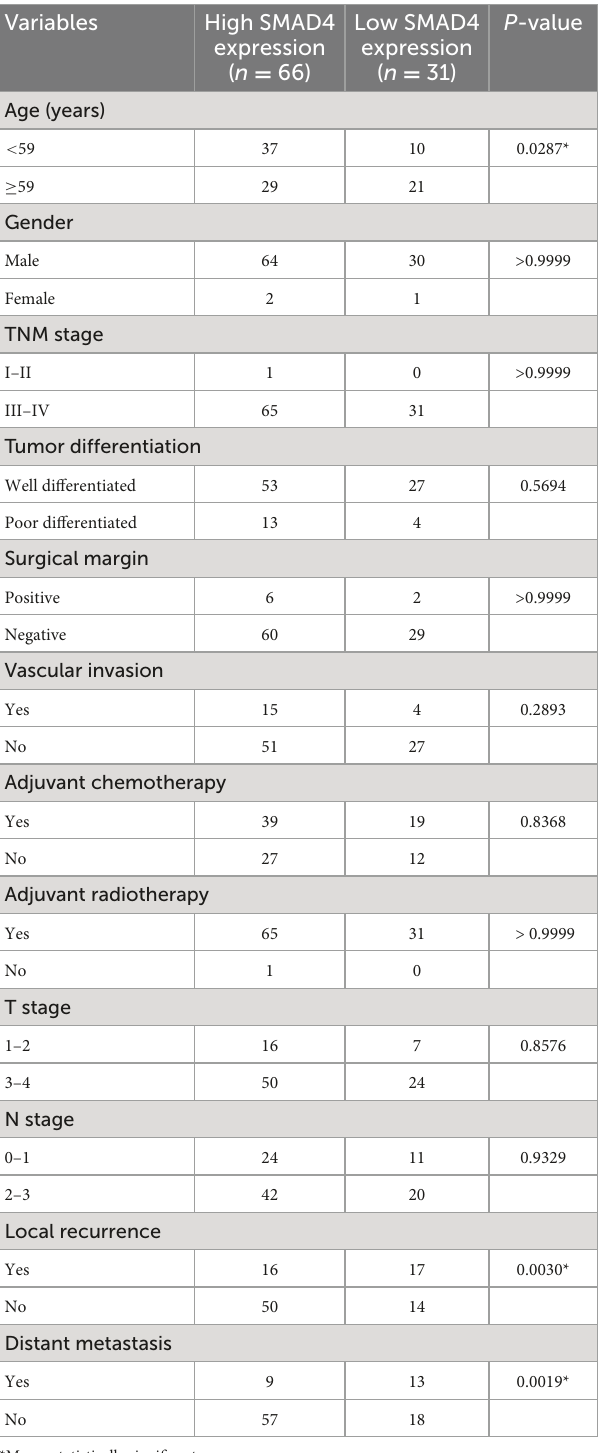
TABLE 1 The relationship between SMAD4 expression and clinical characteristics of HPC